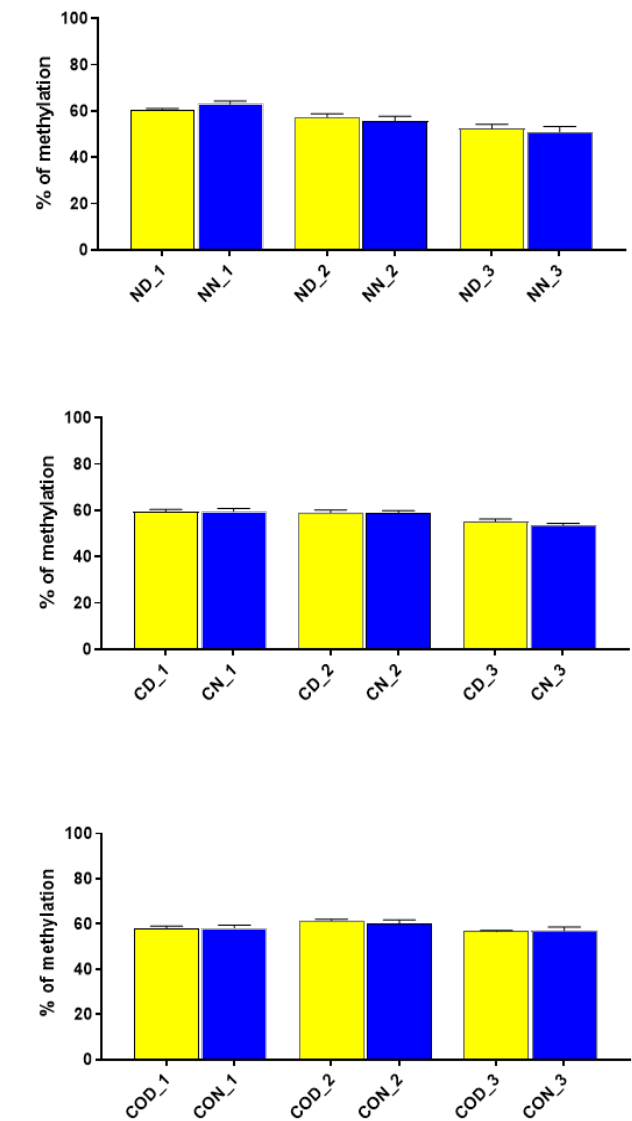
Figure 5. The difference between day (yellow bar) and night (blue bar) methylation levels in the normal (N), control (C) and CO-treated groups of the hypothalamus. The methylation level between − 2402– − 2464 bp in all the experimental groups was approximately 60%. There were no differences in methylation levels between day and night in this region. The bars are represented as mean ± SEM. At the top of the figure is the examined sequence: original ( top ) and bisulfite converted with highlighted methylation position ( bottom ).